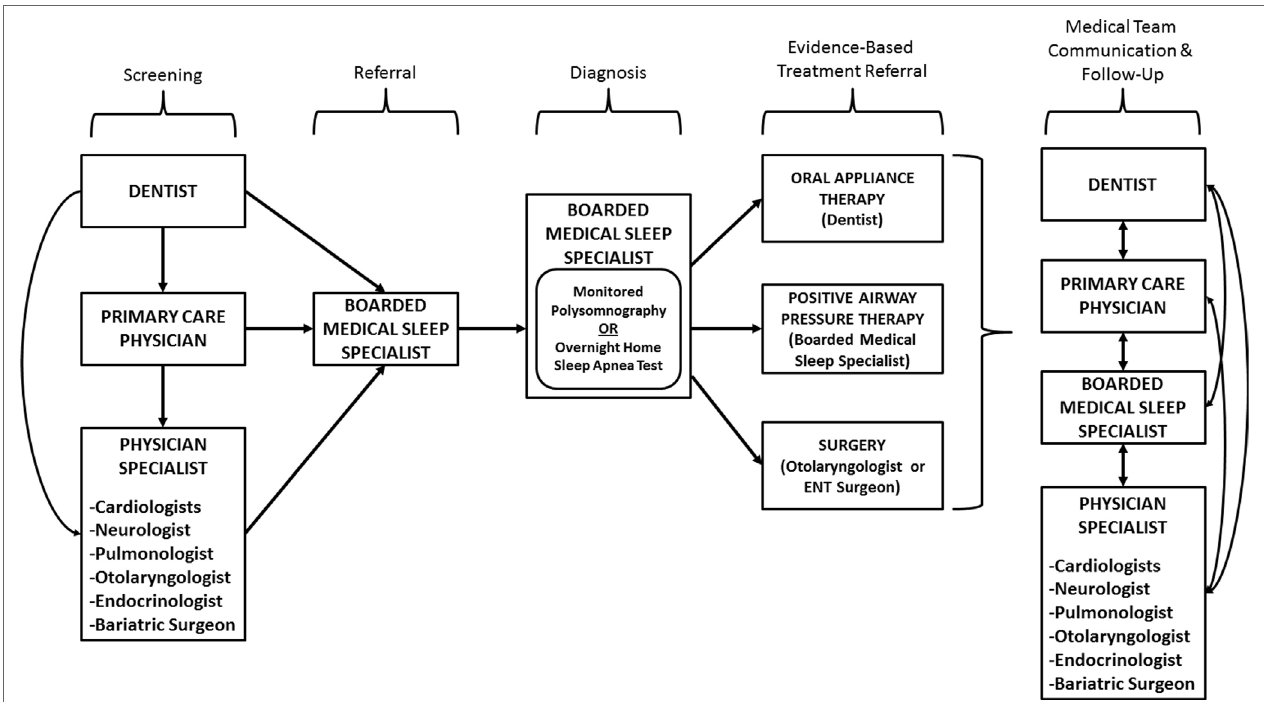
FiGuRE 1 | Involvement of a multidisciplinary medical team in the screening, referral, diagnosis, and treatment